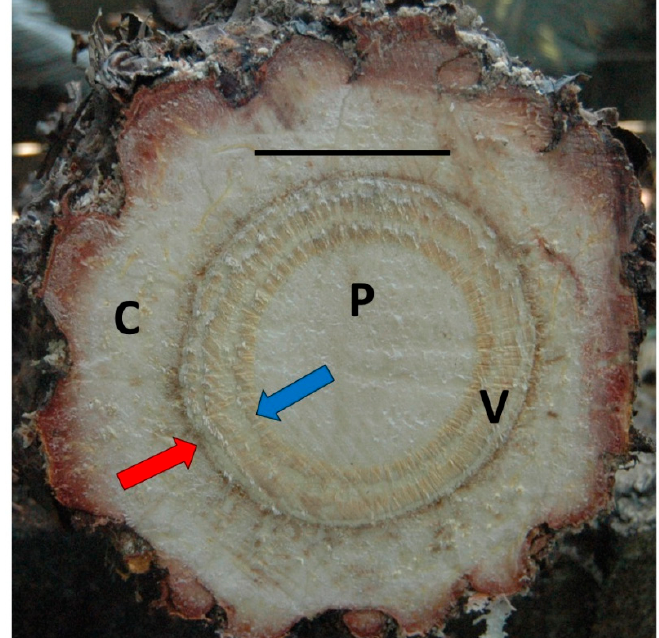
Figure 1. Internal structure of an arborescent Cycas stem shows characteristic live tissues among pith (P), vascular cylinders (V), and persistent cortex (C) radial regions. Blue arrow is oldest vascular cylinder, red arrow is youngest vascular cylinder. Horizontal bar is 10 cm. cylinder, red arrow is youngest vascular cylinder. Horizontal bar is 10